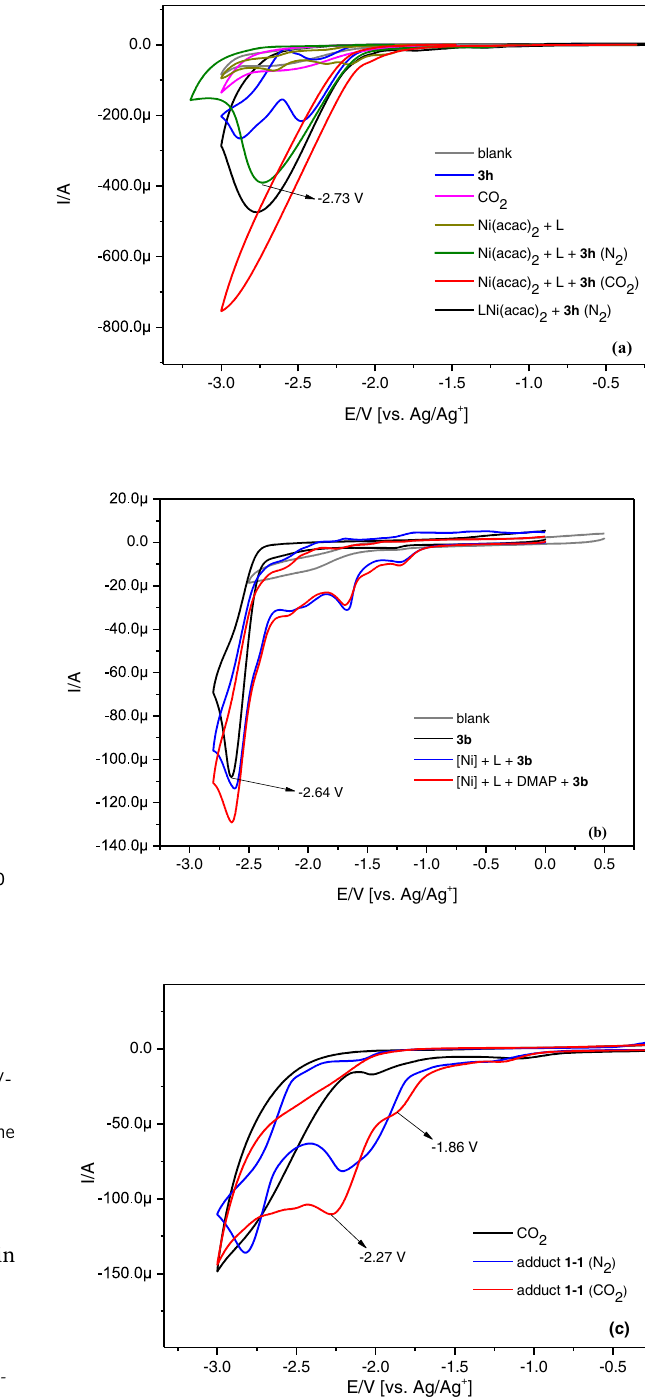
Fig. 7 Performance of nickel catalysts in CV tests. Testing conditions: working electrode, glassy carbon electrode; counter electrode, Pt wire; reference electrode, Ag/AgNO 3 electrode (10 mM AgNO 3 in CH 3 CN). Scan rate: 100 mV/s. Solvent: NMP/ n Bu 4 NPF 6 (0.1 M). Samples were tested under N 2 atmosphere except some cases under CO 2 atmosphere. a CV tests of [Ni(acac) 2 + dtbbpy] and aryl bromide 3 h . Ni(acac) 2 , 3 mM; L, dtbbpy, 3 mM; LNi(acac) 2 , 3 mM; 3 h , ethyl 4-bromobenzoate, 60 mM; CO 2 (bubbled in the solution for 10 min). b CV tests for the role of DMAP. [Ni], NiBr 2 (DME), 3 mM; L, dtbbpy, 3 mM; DMAP, 3 mM, 3b , 4- bromophenyl, 5 mM. c CV tests of adduct 1-1 . adduct 1-1 , 5 mM; CO 2 (bubbled in the solution for 10 min). L, dtbbpy, 4,4 ′ -di-tert-butyl-2,2 ′ - bipyridine; DMAP,